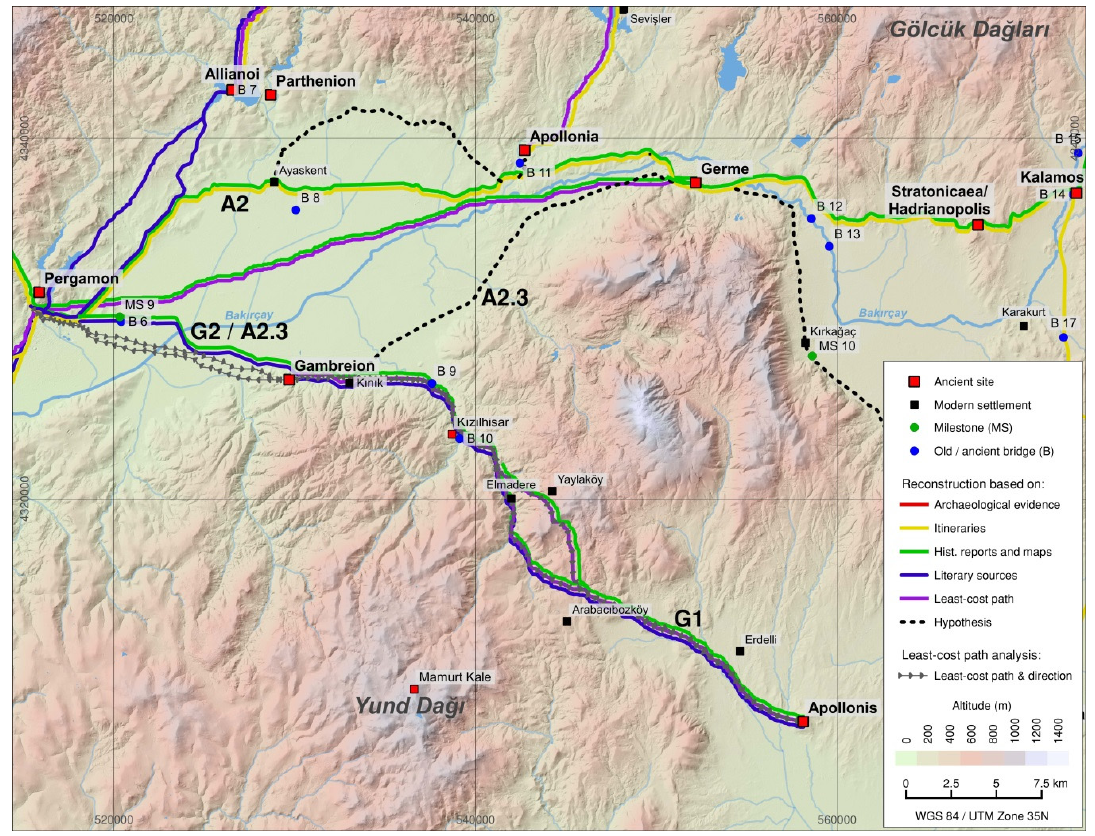
Figure 18. Calculated least-cost paths and reconstructed routes between Apollonis and Pergamon via